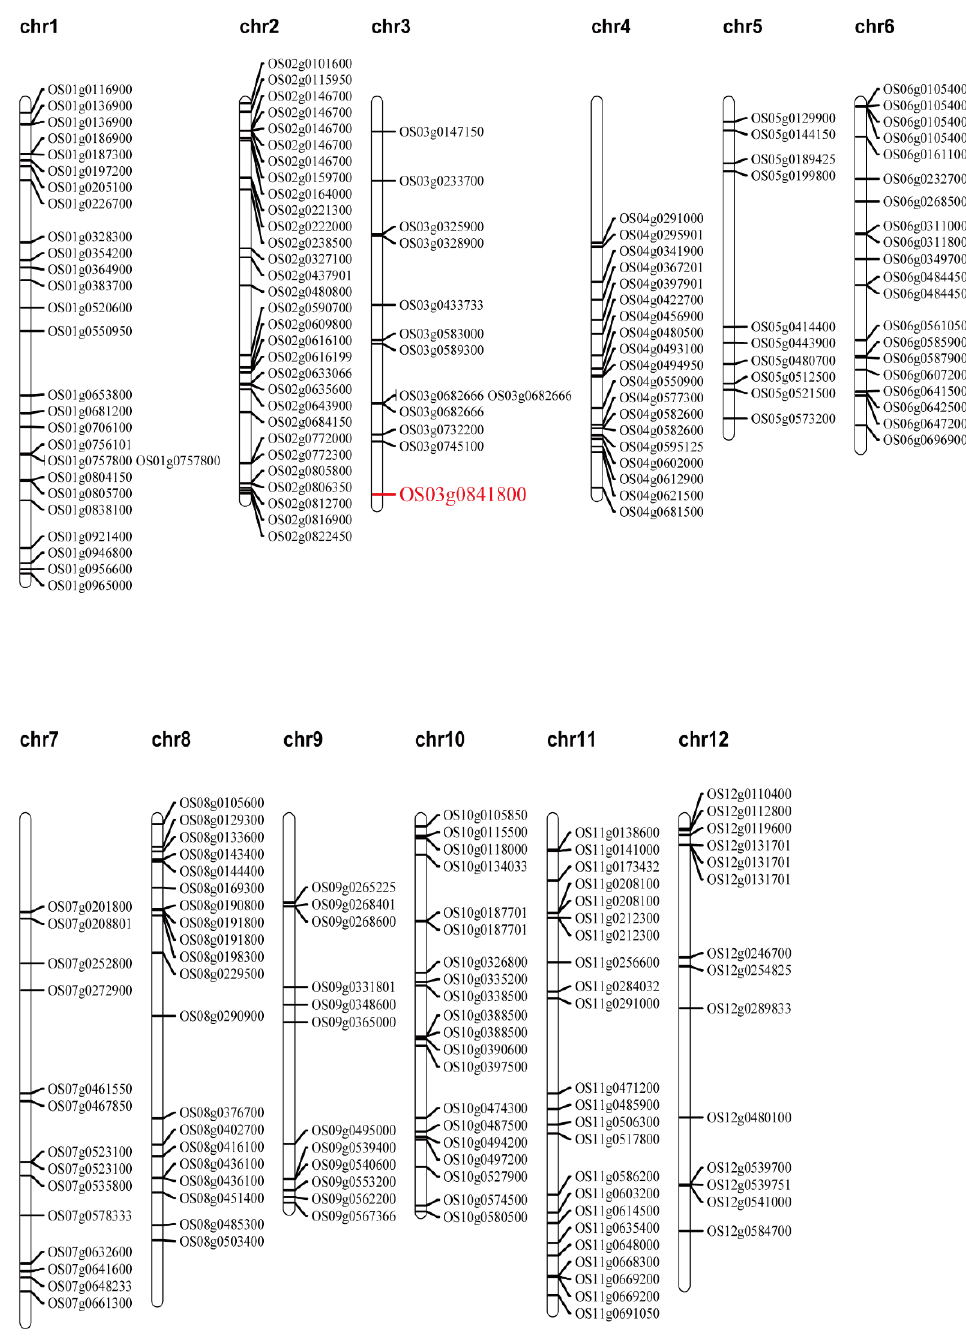
Figure 6. Distribution of identified splicing sites, which compared the whole genome sequencing of CG with the Nipponbare reference